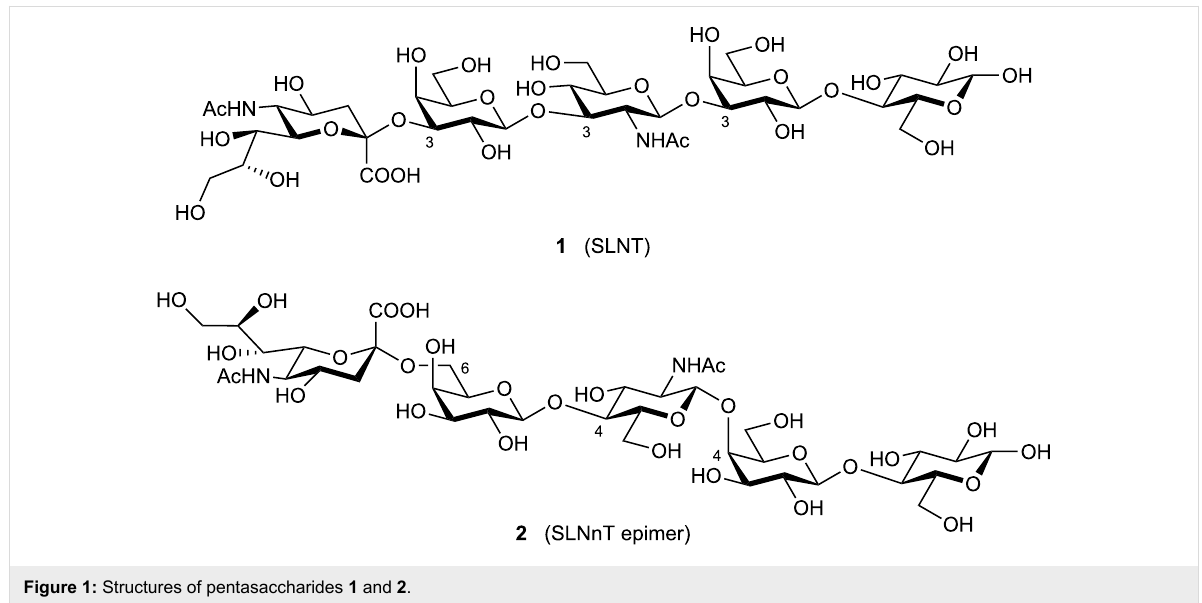
Figure 1: Structures of pentasaccharides 1 and 2